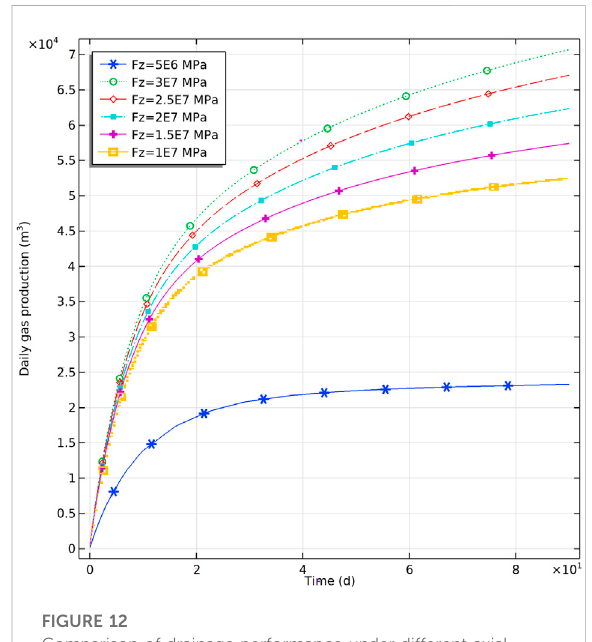
FIGURE 12 Comparison of drainage performance under different axial